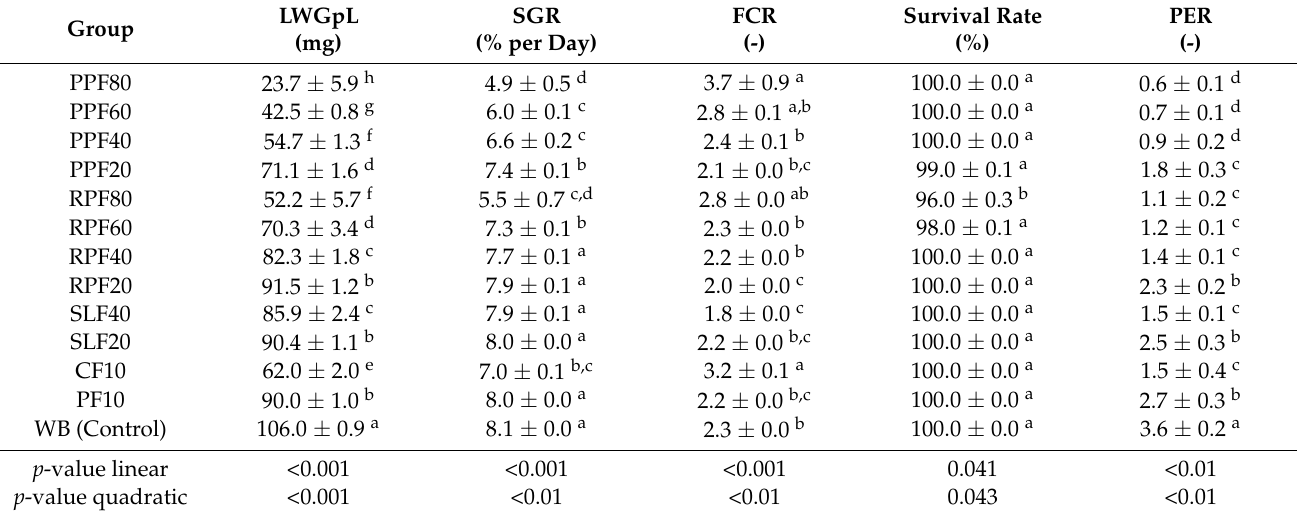
Table 5. Growth performance, feed and protein utilization efficiency, and survival rate of Tenebrio molitor larvae of different feeding groups. Values are given as mean ± standard deviation, n =